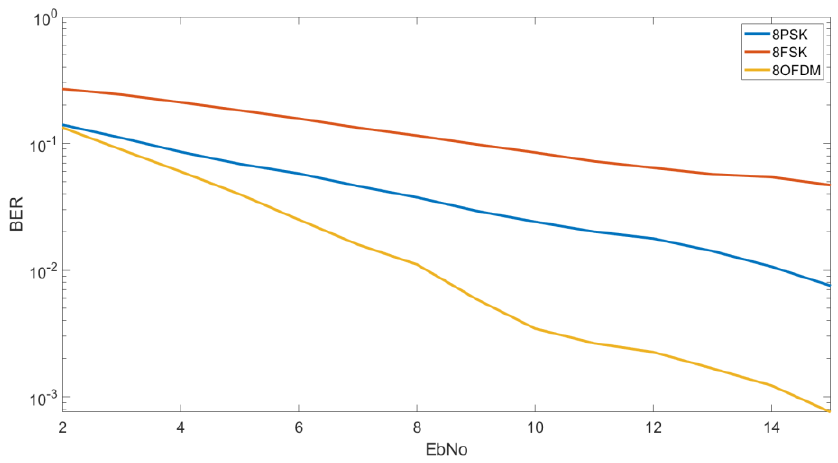
Figure 6. BER vs. E b / N 0 M = 8.